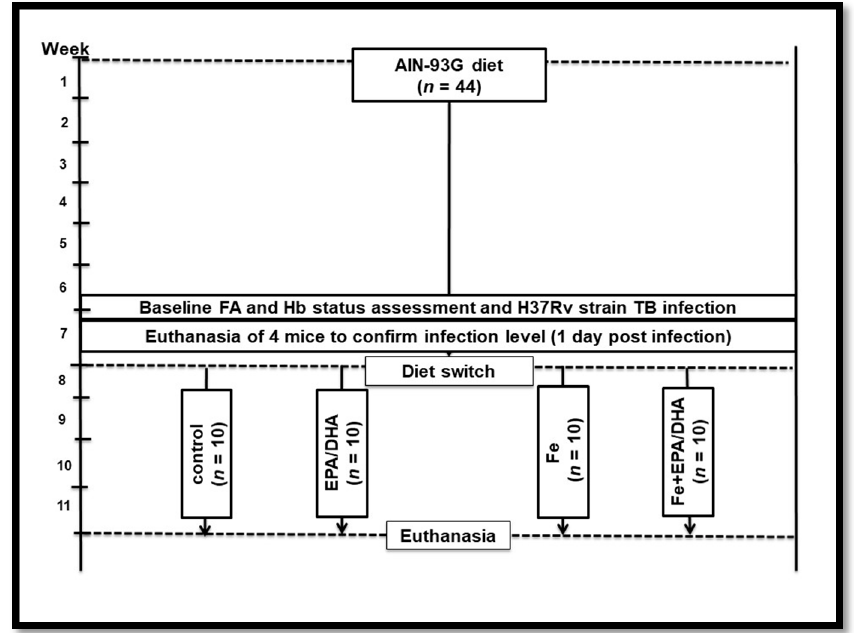
Figure 1. Experimental study design. EPA / DHA: eicosapentaenoic and docosahexaenoic acid supplemented group; FA: fatty acid; Fe: iron supplemented group; Fe + EPA / DHA: iron and eicosapentaenoic and docosahexaenoic acid supplemented group; Hb: hemoglobin.